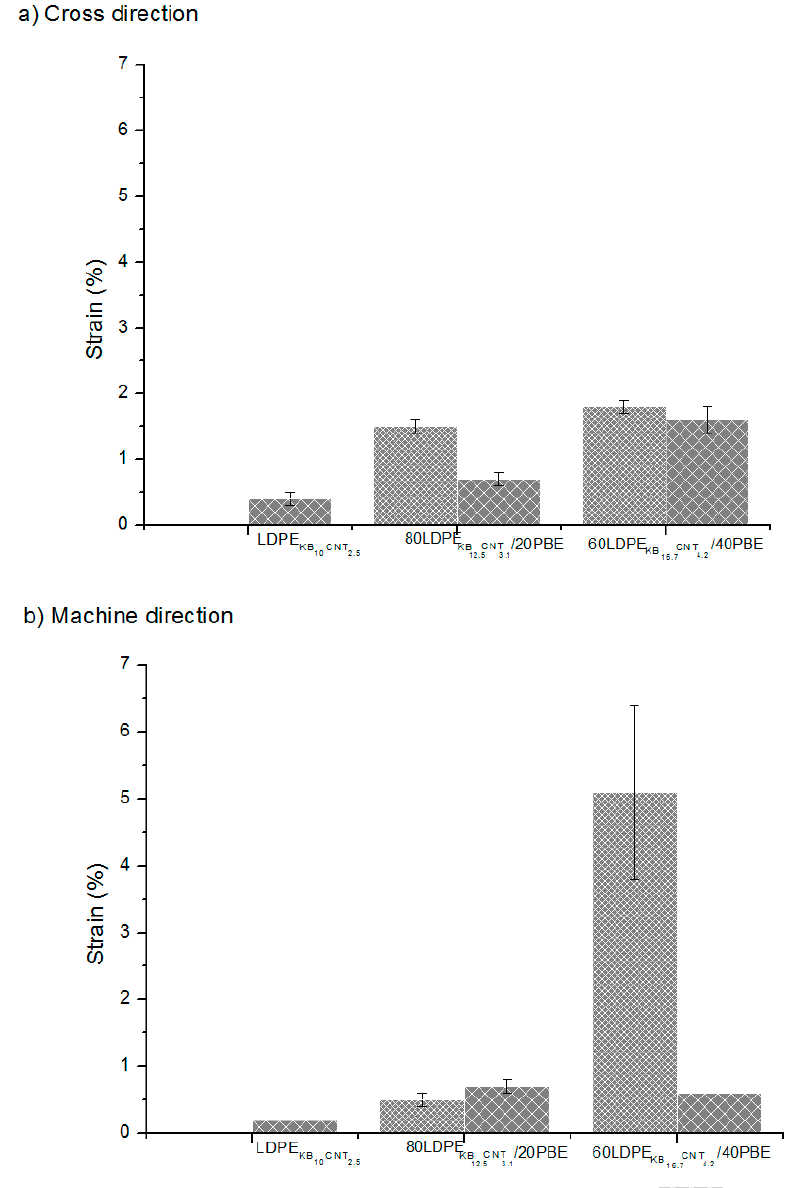
Figure 25. Strain (%) of the conducting biphasic blends produced by a 1-step ( ) or 2-step ( ) extrusion 3D-printed onto textile materials in the cross ( a ) and machine ( b ) directions of the fabric.